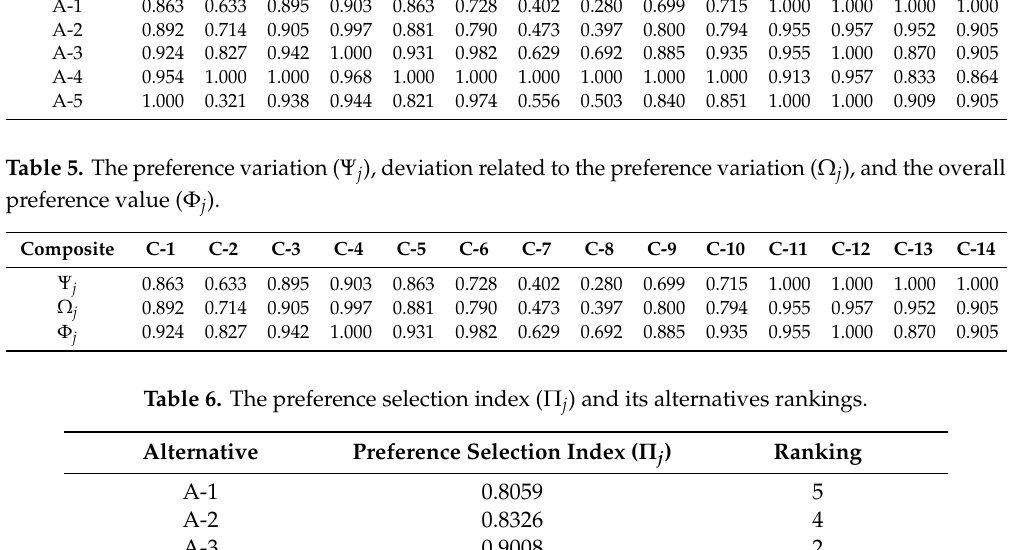
Table 4. The normalized matrix, the deviation ( Ω j ) from the preference variation value ( Ψ j ) together